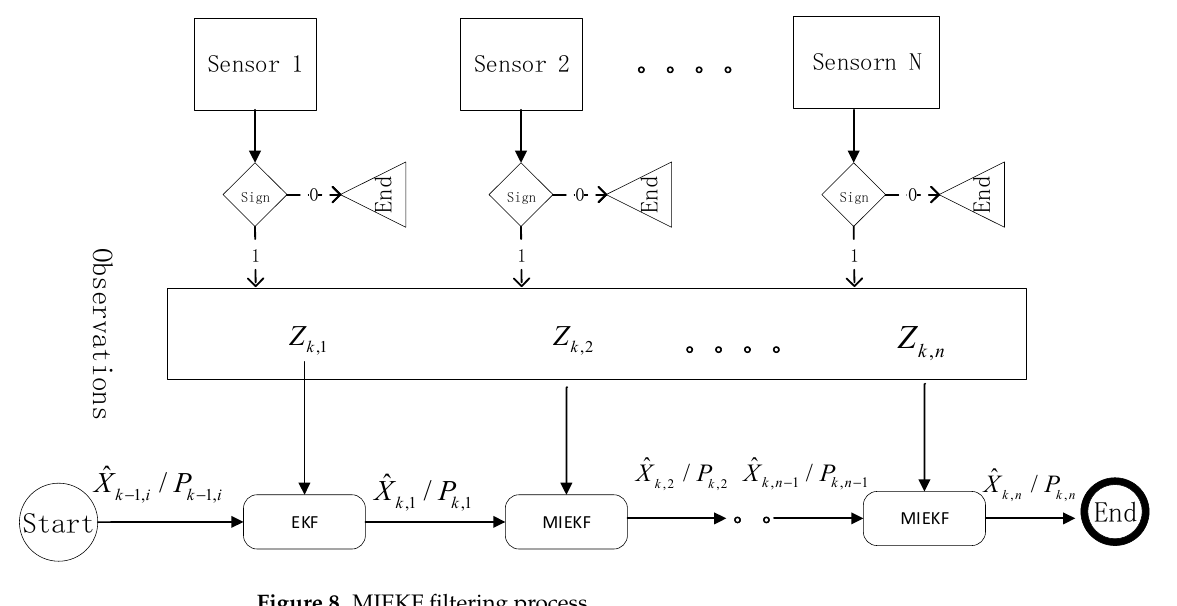
Figure 8. MIEKF filtering process.